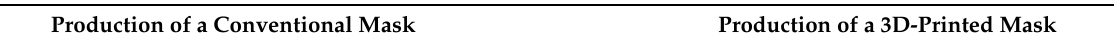
Table 8. Comparison of final costs, per year, between the conventional process and the proposed 3D printing